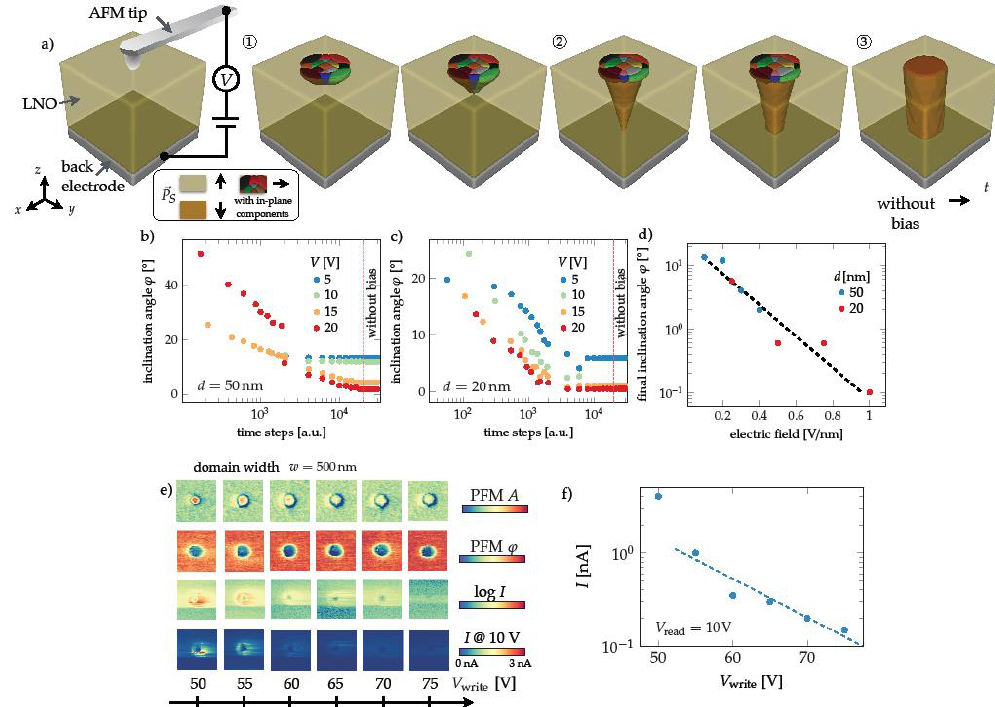
Figure 2. ( a ) Three-dimensional phase field simulation of CDW formation under an AFM tip for a 20 nm thick lm at 20 V. ① Nucleation, ② through domain formation until equilibrium under external bias, ③ equilibrium domain after removal of bias. ( b , c ) evolution of inclination angle for film thicknesses, d, of 50 nm and 20 nm respectively; ( d ) equilibrium inclination angle after removal of bias as a function of applied field; ( e ) measured current I read at a bias voltage of 10 V for domains written at various writing voltages V write , for comparison PFM scans; ( f ) extracted maximum domain wall current.